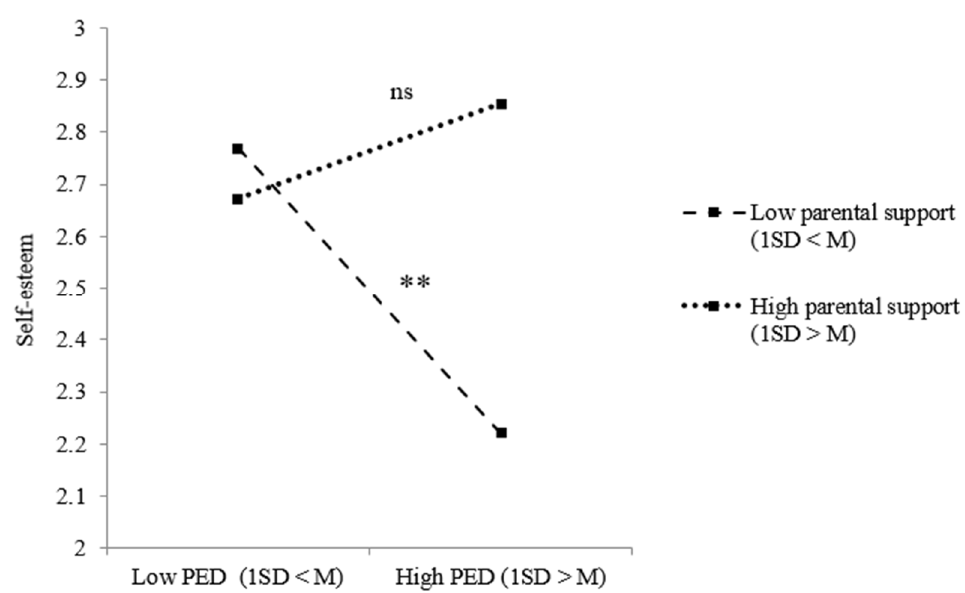
Figure 6. Effects of PED on youth of immigrant descents’ self-esteem dependent on the level of parental support. Note: ** p < 0.01; ns = not significant.